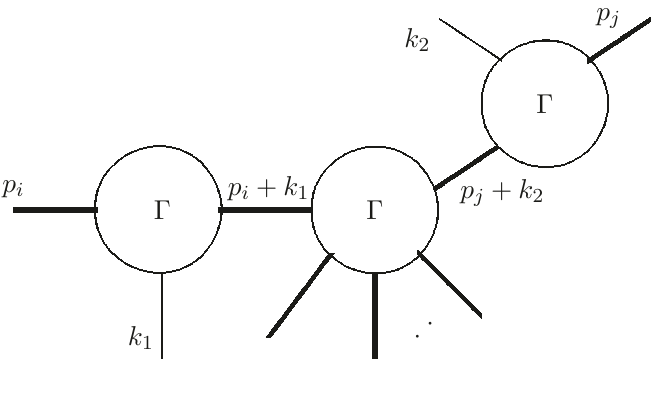
Figure 3 . Two external soft gravitons attached to different external lines carrying finite